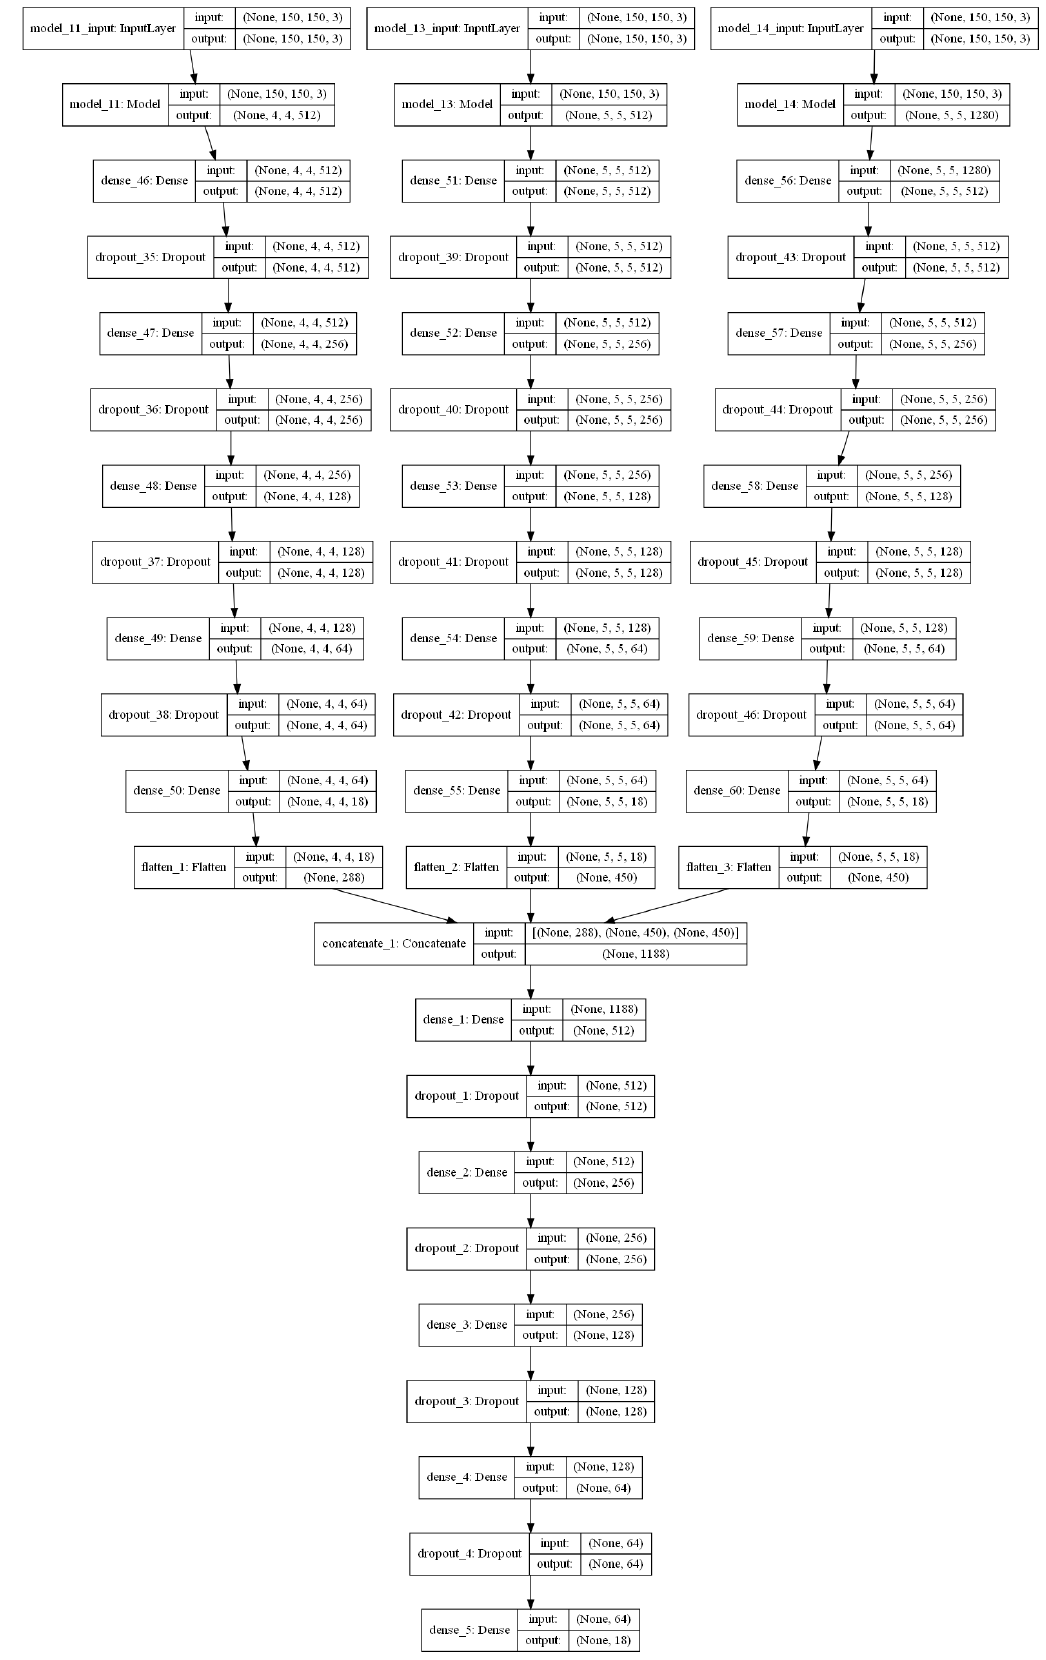
Figure 7. Stacked ensemble model .